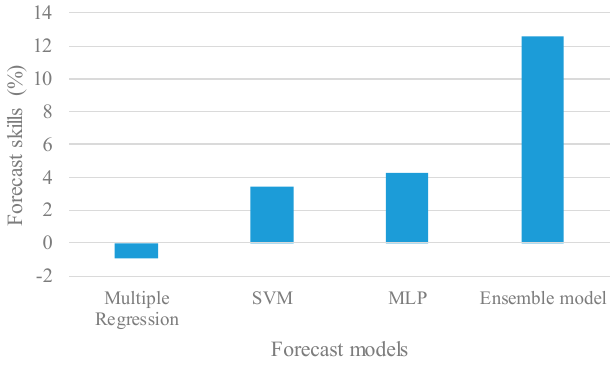
Figure 9. Fs of the last 4 models in Table 5 compared with the persistent model.